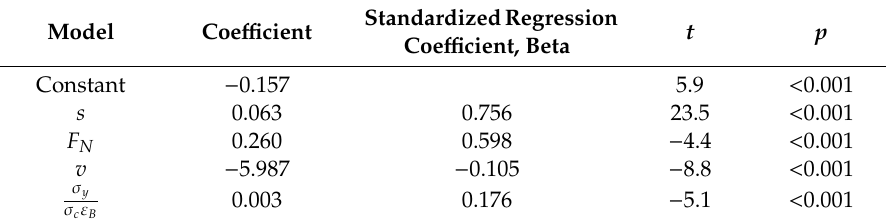
Table 6. Coe ffi cients of the regression model with P150